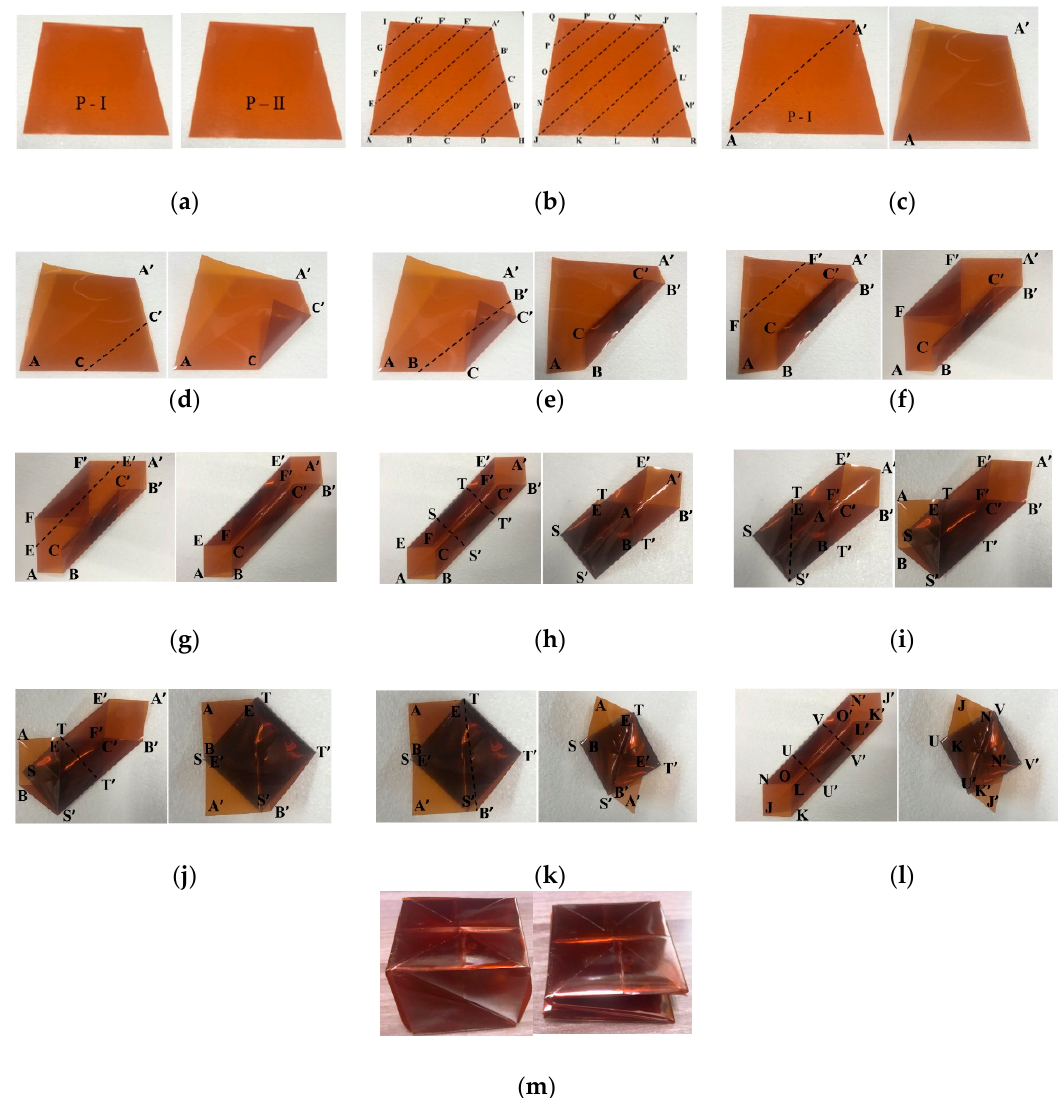
Figure 5. Magic cube origami folding process to fabricate the proposed single antenna element. ( a ) selection of two sheets of Kapton film, ( b ) sheets marked with alphabets, ( c ) folding sheet P-I along AA', ( d ) folding along CC', ( e ) folding along BB', ( f ) folding along FF’, ( g ) folding along EE', ( h ) dividing sheet into three segments and folding along S'S, ( i ) folding along TS', ( j ) folding along TT', ( k ) folding along TB', ( l ) folded sheet P-II, ( m ) unfolded and folded states for magic cube